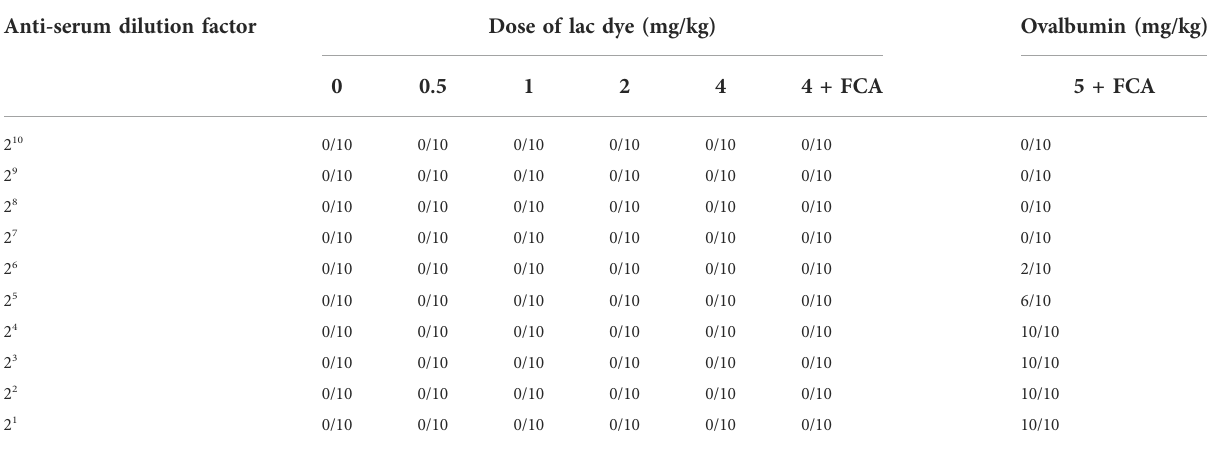
TABLE 4 Frequency of positive response in the passive cutaneous anaphylaxis test on lac dye. Anti-serum dilution